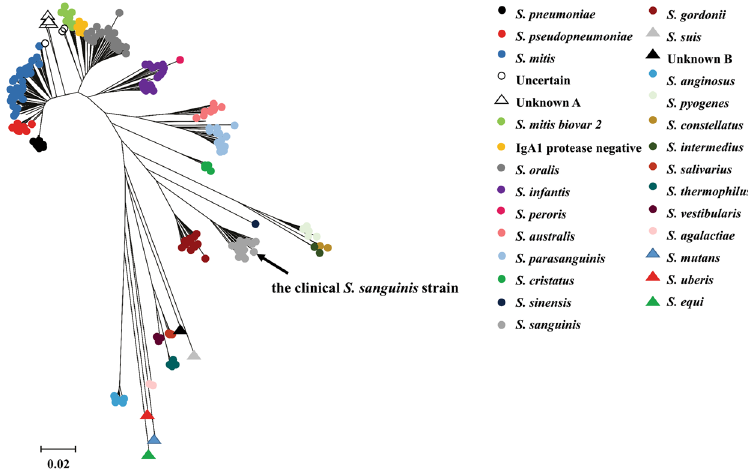
Figure 4. Phylogenetic tree of the clinical S . sanguinis